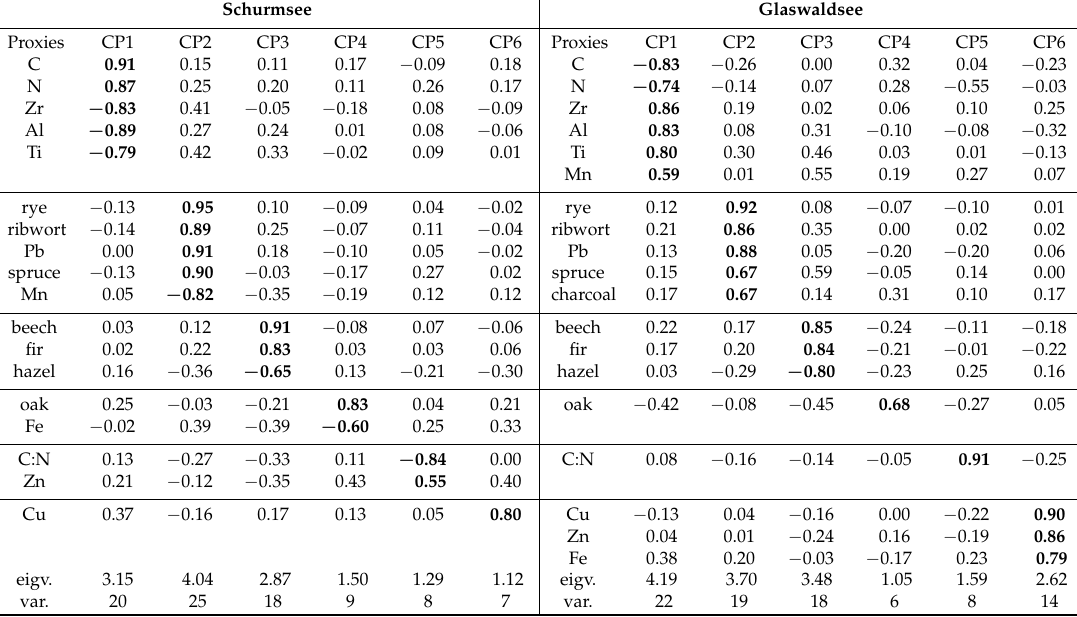
Table 1. Factor loadings of six component (CPs) extracted by PCA using the pollen and geochemical element composition of the two Black Forest sediment cores: eigv.—eigenvalues, var.—percentage of proportional variance explained by each component. For reasons of comparability, no strict sorting according to loadings and eigenvalues was